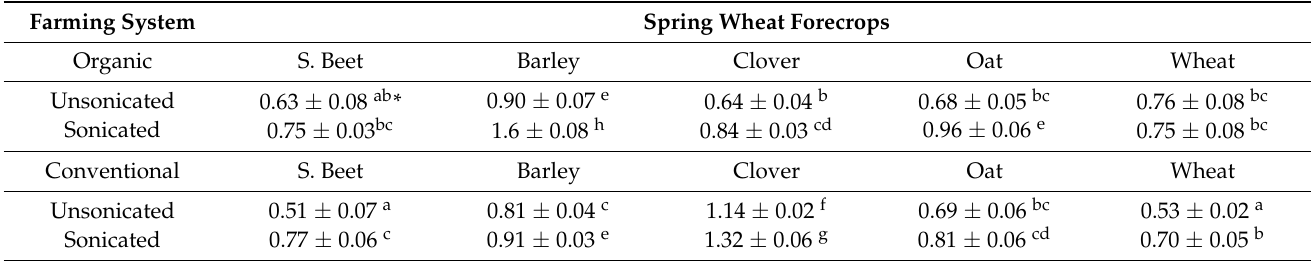
Table 13. Roughness parameter, R q ( µ m), of wheat gluten surface (surface = 0.9 × 1.3 mm).